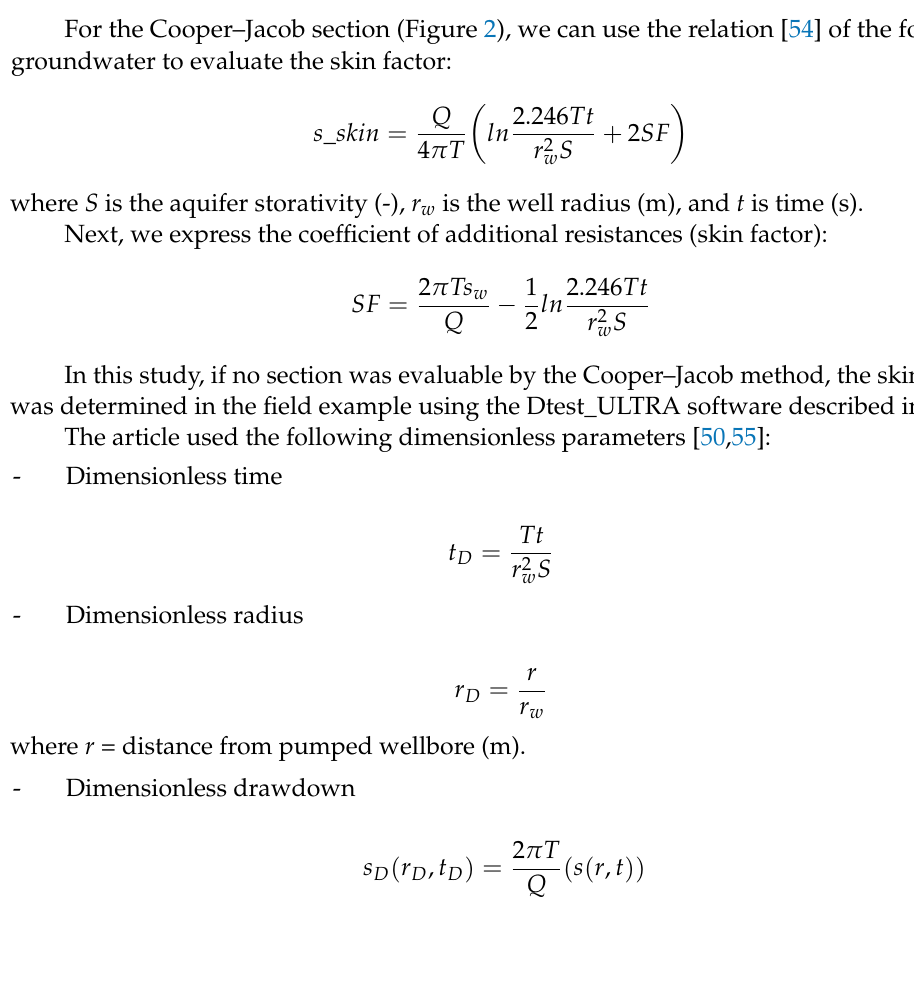
Figure 2. Diagram of a pumping test with the initial section and the Cooper – Jacob section.